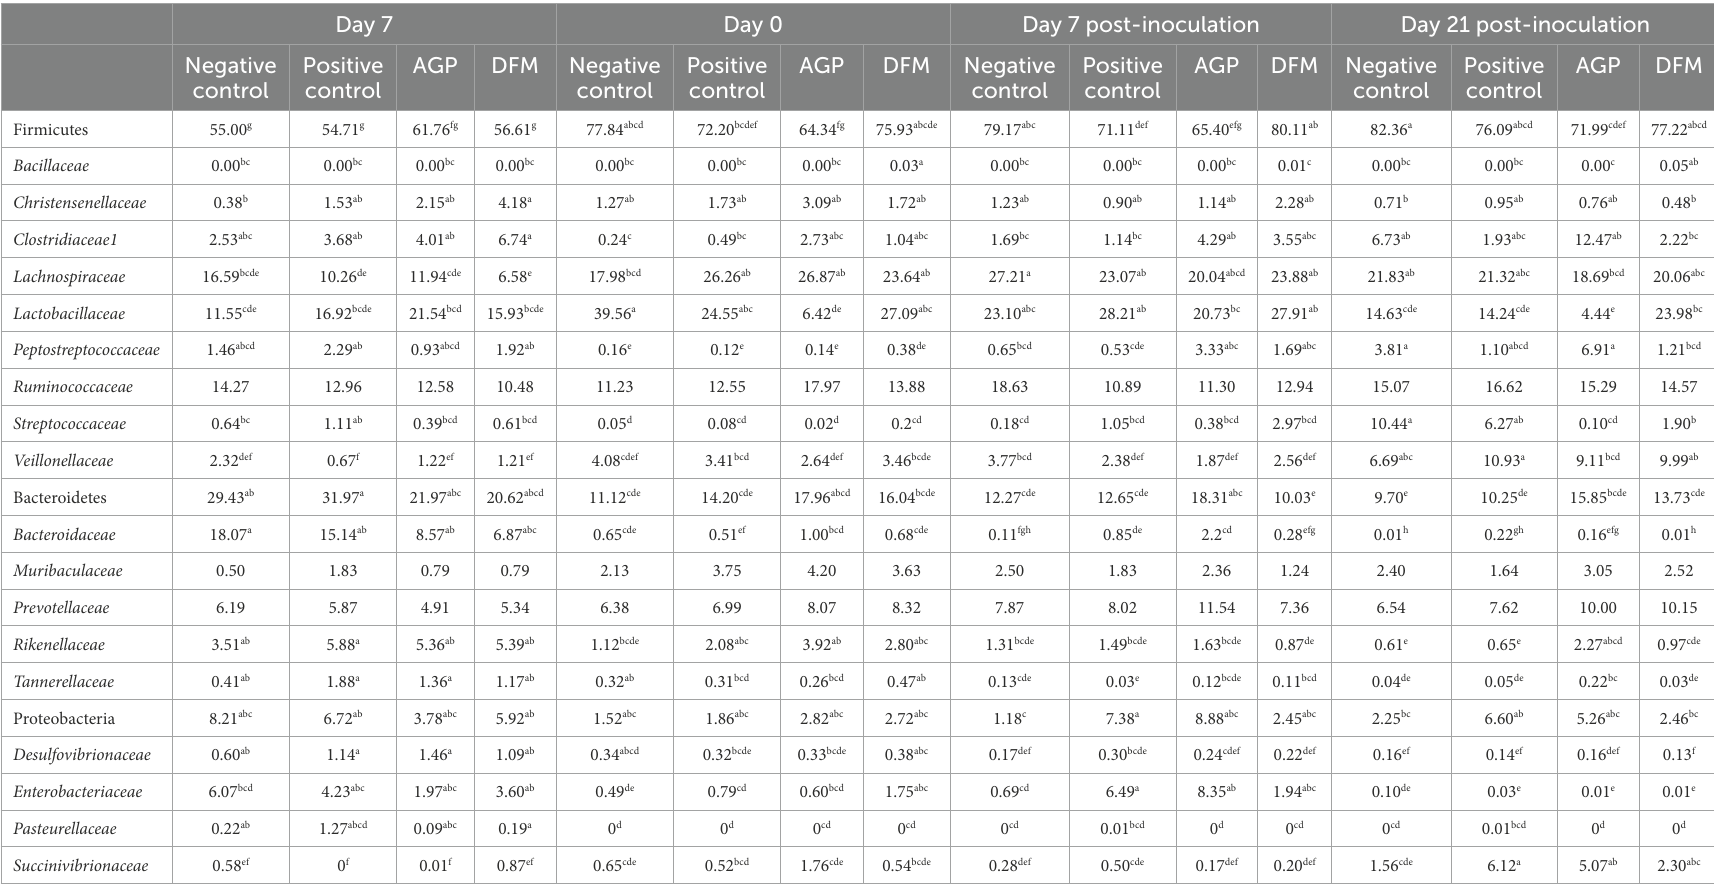
TABLE 2 Relative abundance (%) of Firmicutes, Bacteroidetes, and Proteobacteria and their top families in feces of enterotoxigenic Escherichia coli challenged pigs fed diets supplemented with antibiotics (AGP) or Bacillus subtilis